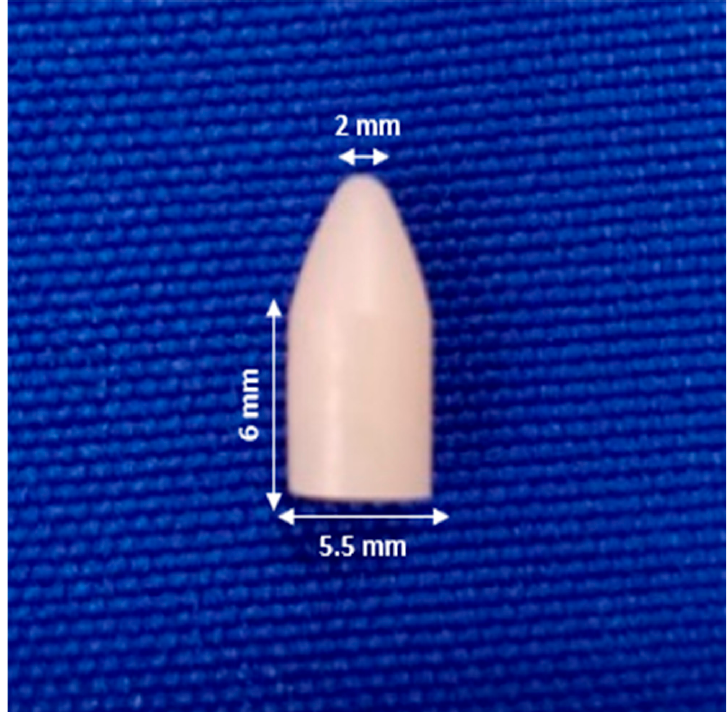
Figure 1. Dimensions of hemispheres.